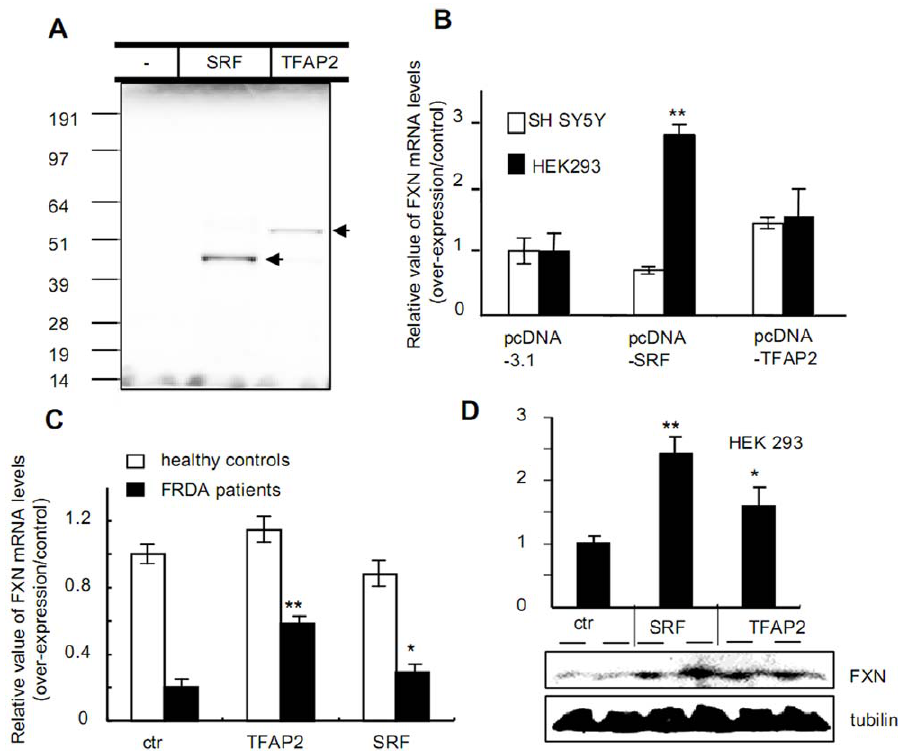
Figure 5. Overexpression of SRF or TFAP2 enhances frataxin expression in HEK293 cells and Friedreich ataxia patient lymphoblasts. (A) In order to assess the effect of over-expression of SRF or TFAP2 on frataxin expression, plasmids pcDNA-SRF and pcDNA-AP2 were constructed and the correct sizes of the translation products of the cloned SRF and TFAP2 cDNA were verified by in vitro translation with [ 35 S]- labeled methionine. The plasmid constructs were then transfected into HEK293 or SH SY5Y cells (B), or lymphoblasts (C) derived from healthy individuals (GM15799, GM16215) or Friedreich ataxia patients (GM16179, GM16214), and frataxin mRNA levels were measured by qRT-PCR (see MATERIALS and METHODS). Empty plasmid pcDNA3.1(-) was used as a control for comparison. The results from two different experiments were similar; the data presented here are average values from the two experiments. Levels of mature frataxin protein were determined by western blot (D). A representative western blot is shown here for HEK293 cells. Three separate experiments were carried out, and for each experiment